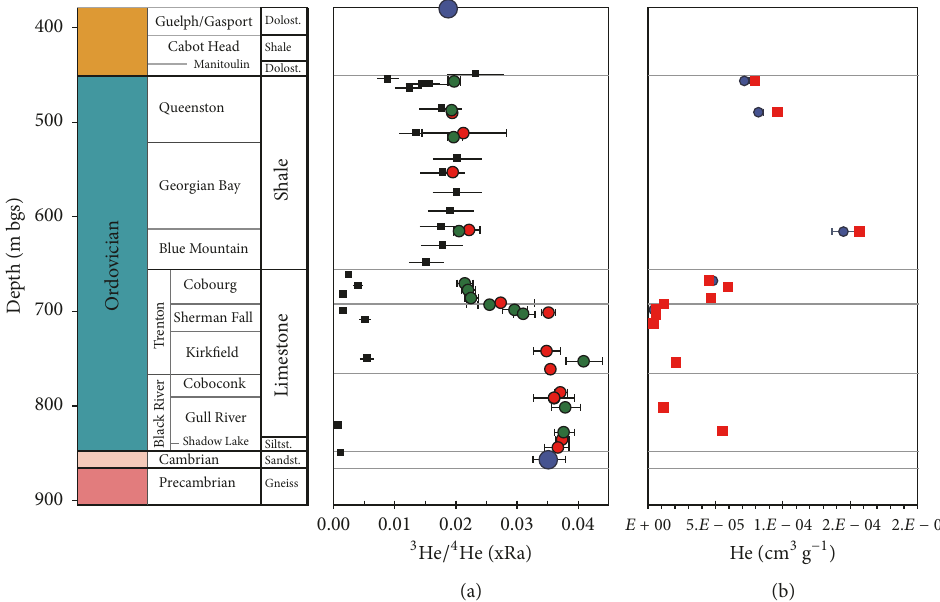
Figure 4: (a) Helium isotope ratios in deep geologic repository (DGR) DGR-2 (green circles) and DGR-3 (red circles) cores normalized to air [xRa = ( 3 He/ 4 He) sample/( 3 He/ 4 He) air; where ( 3 He/ 4 He) air is 1.38 × 10 – 6 ], calculated isotope ratios (black squares) based on decay of U and Th ( 4 He) and fission of 6 Li ( 3 He) from calculations of neutron flux (Ballentine and Burnard, 2002), and groundwaters (blue circles). (b) 4 He concentration (cm 3 STP g – 1 rock; STP—standard temperature and pressure) in DGR-2, measured by step-wise extractions, corrected for losses using exponential extrapolation model (red squares) and three-dimensional numerical diffusion model (blue circles) (mbgs—meters below ground surface). Figure and caption from Clark et al.